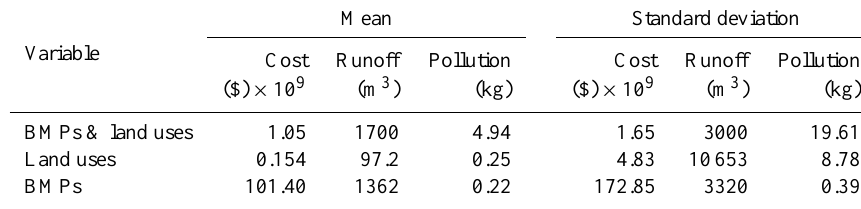
Table 6. Sensitivity analysis in variable selection after 200 generations.